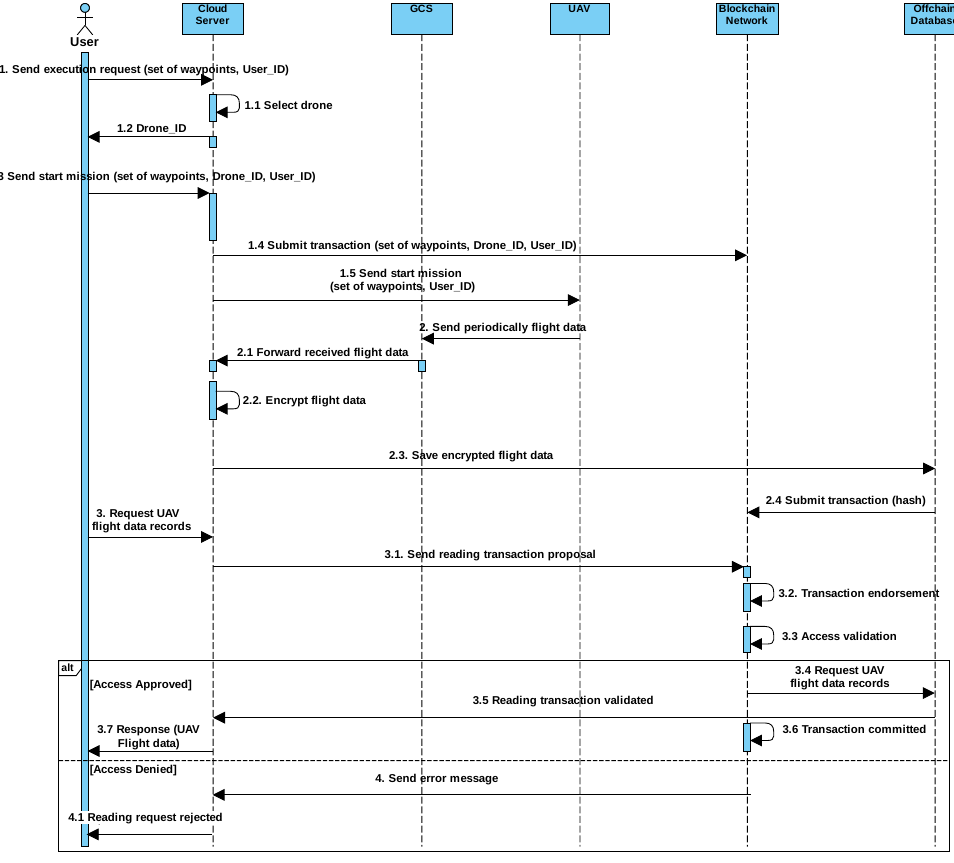
Figure 2. Search mission sequence